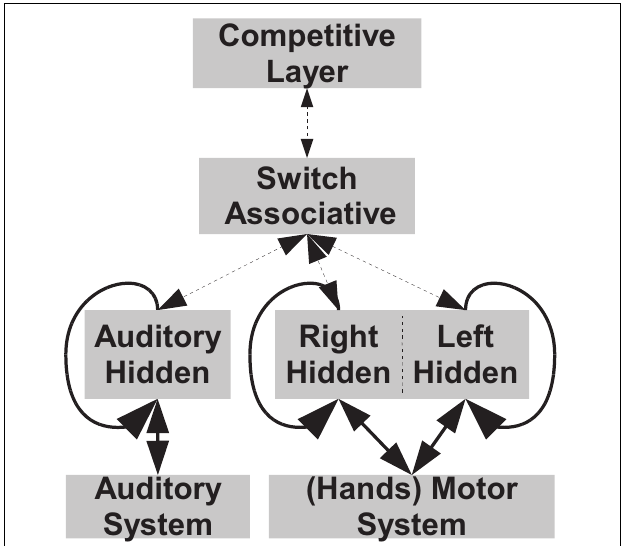
FIGURE 2 | Schematic of the Robot’s Cognitive System. In the lower part are the units of the motor controller/memory and of the auditory sub-systems, they are directly connected with the robotic platform. In the upper part there are the units with abstract functions that are the switch/associative network and the competitive layer classifier. Bold links indicate a full (one-to-all) connection between each layer, while dotted links are direct (one-to-one) connections. Note that the system’s external inputs coincide with the outputs, indeed proprioceptive information from motor and auditory systems is an input for the system during the training phase, while it is the control output when the system is operating.